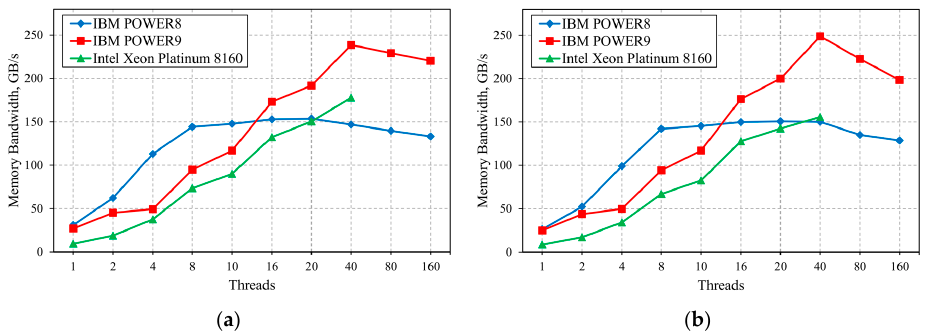
Figure 1. Benchmark results for Copy ( a ) and Scale ( b ) kernel. Electronics 2020 , 9 , x FOR PEER REVIEW